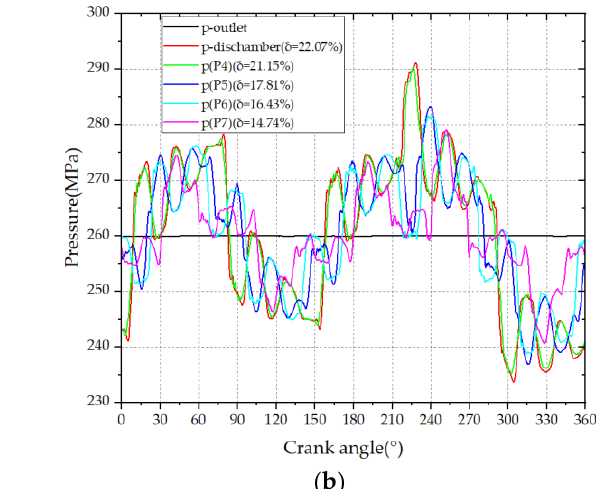
Figure 10. Pressure pulsation in the pipelines. ( a ) Pressure pulsation in the inlet pipeline; ( b ) pres- sure pulsation in the inlet pipeline.